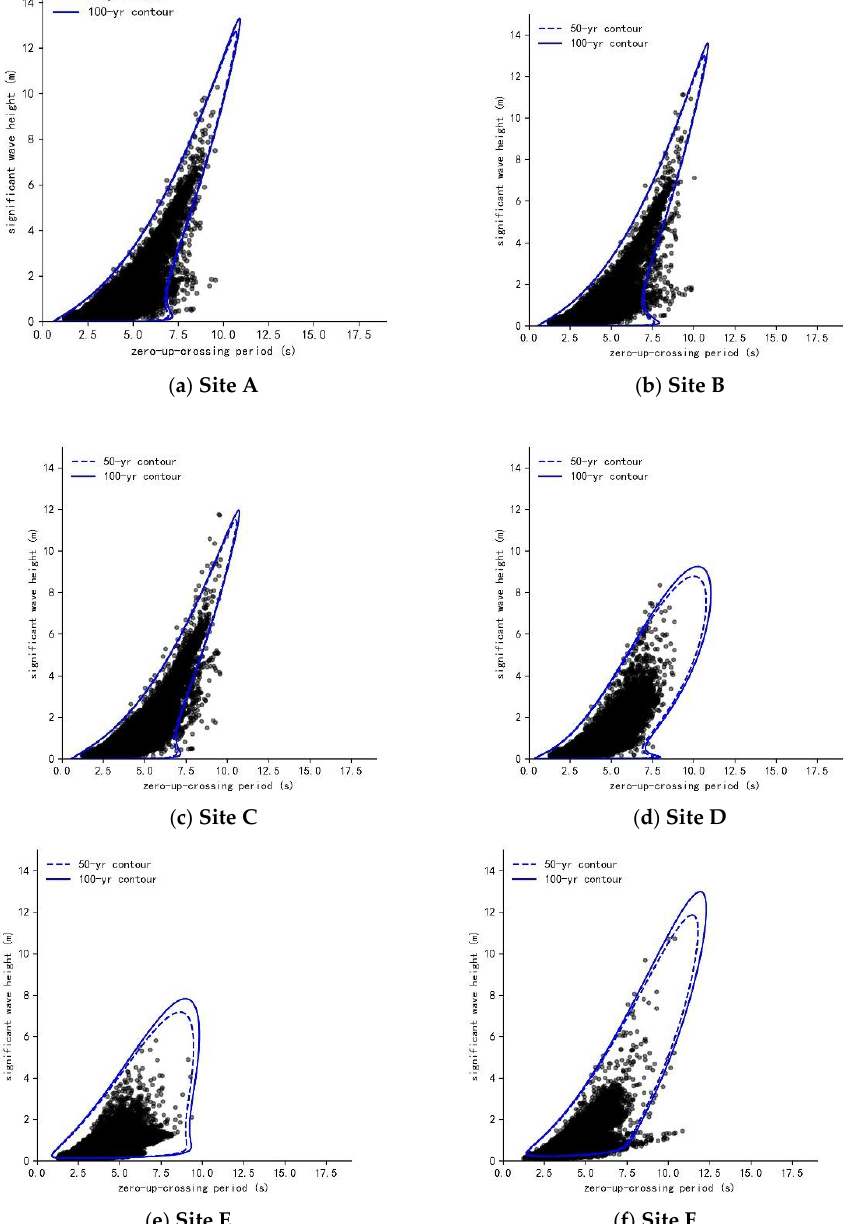
Figure 30. Corresponding contour plots of sea-state parameters at reference sites in the Xisha Islands. After the environmental contour method was estimated, the maximum Hs on the 100-year return contour line was selected. The single-value extreme value analysis results were compared with the environmental contour results in Table 6. Generally, the 100-year return level Hs estimated using the Environmental Contour method was close to the GEV results. An ad- vantage of the Environmental Contour method was that it could avoid the unrealistically large values that could appear in the extreme-value analysis results. Table 6. Comparison between extreme value analysis results and environmental contour results at the 100-year return level.